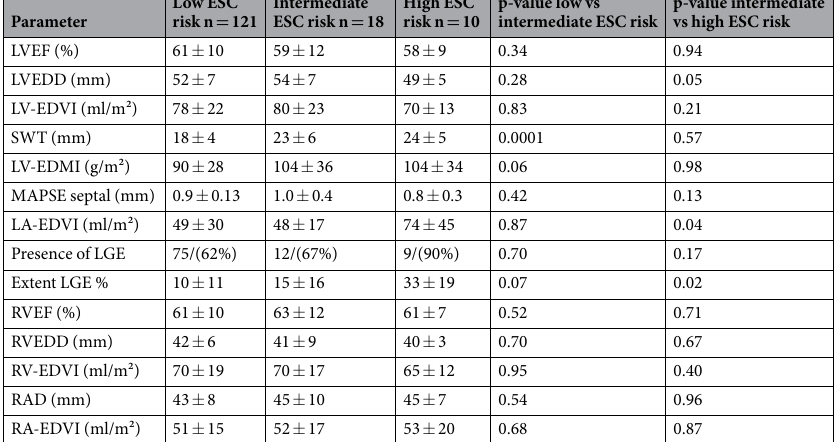
Table 2. CMR characteristics according to ESC risk scores. Data are presented as ± standard deviation. Volumes are indexed to body surface area. Abbreviations: LVEF = left ventricular ejection fraction, LVEDD = left ventricular end diastolic dimension, LVEDMI = left ventricular end diastolic mass index, LV- EDVI = left ventricular end diastolic volume index, LA = left atrial, LGE = late gadolinium enhancement, LV = left ventricular, MAPSE = mitral annular plane systolic excursion, PWT = posterior wall thickness, RAD = right atrial diameter, RVEF = right ventricular ejection fraction, SWT = septal wall thickness, RA- EDVI = right atrial end diastolic volume index.